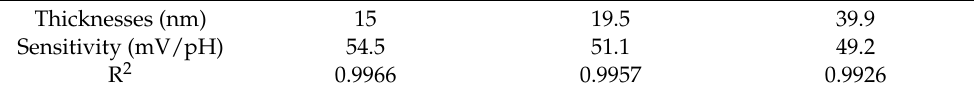
Table 1. Comparison of the sensitivity of various HfO 2